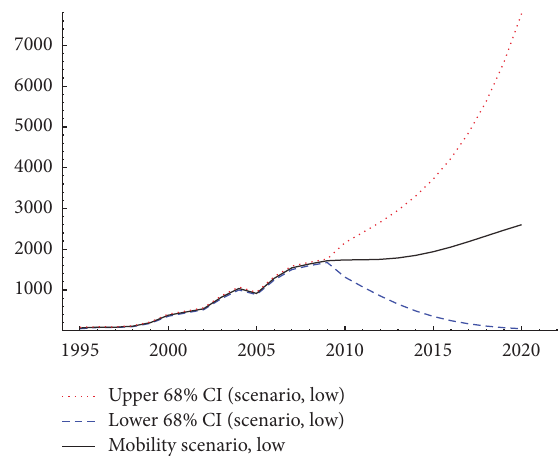
Table4:ForecastedabsolutenumbersofCambodianfatalitiesinthe